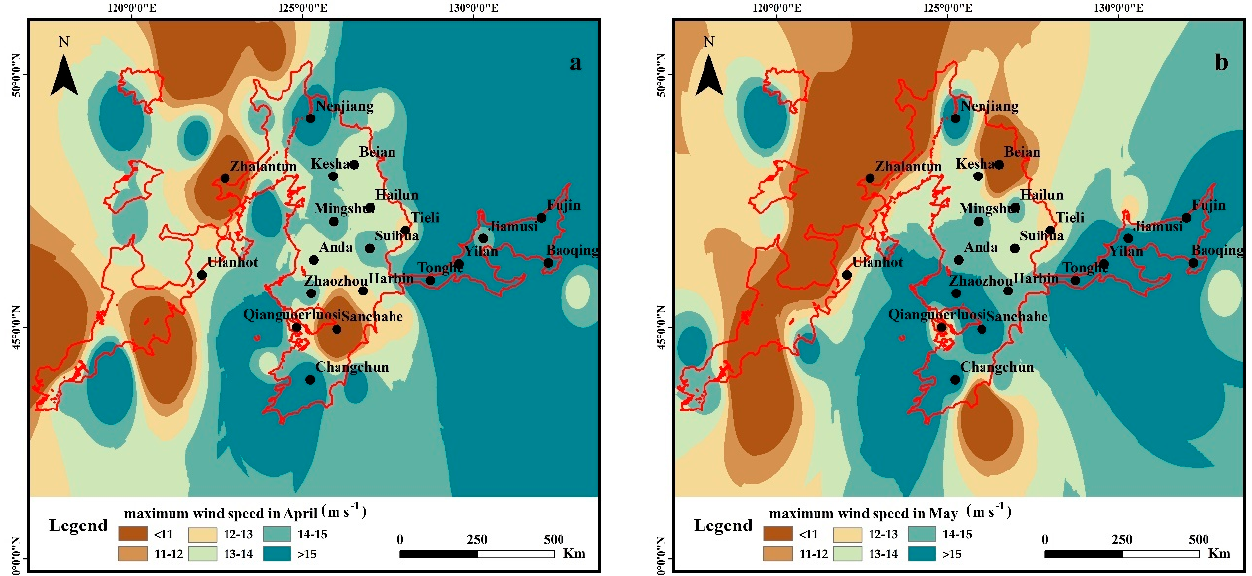
Figure 8. Spatial distribution of the maximum wind speed variation in April and May (( a ): April, ( b ): May).